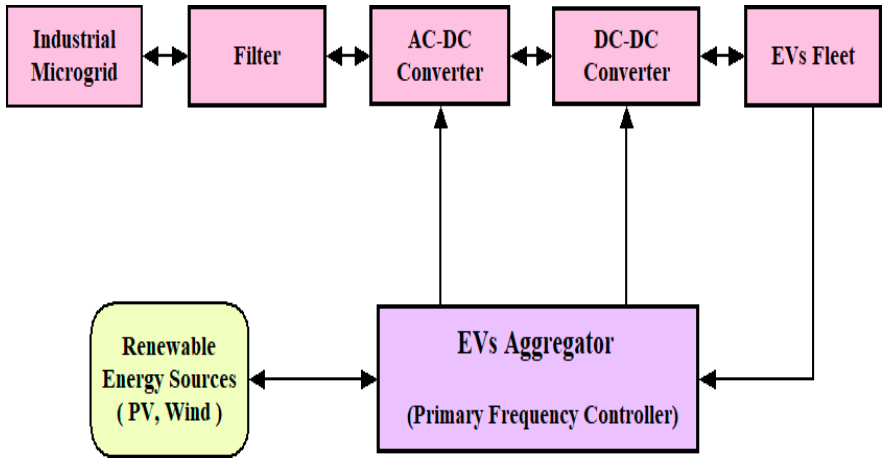
Figure 4. Block diagram of V2G system for an IMG. For G2V Mode: P T > 0, EV works in charging